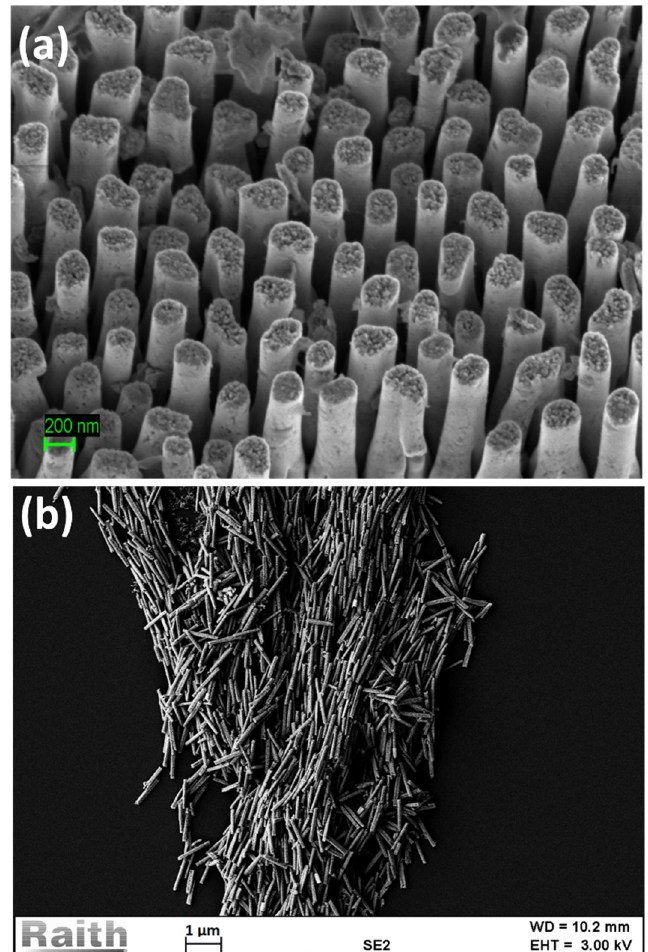
Figure 4. ( a ) SEM micrograph image of CoFe nanowires released from the nanoporous alumina membrane; ( b ) SEM micrograph image of core–shell nanowires with CoFe magnetic core and Au coating.